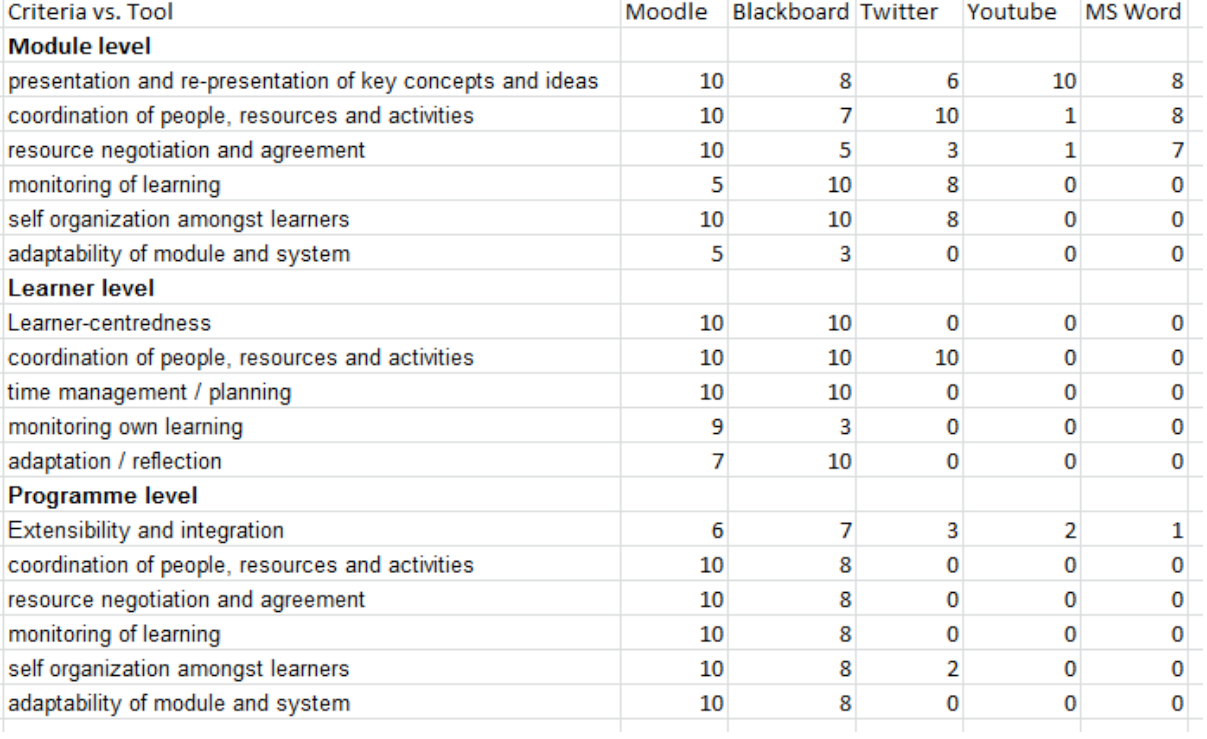
Figure 3. E-Learning tools database